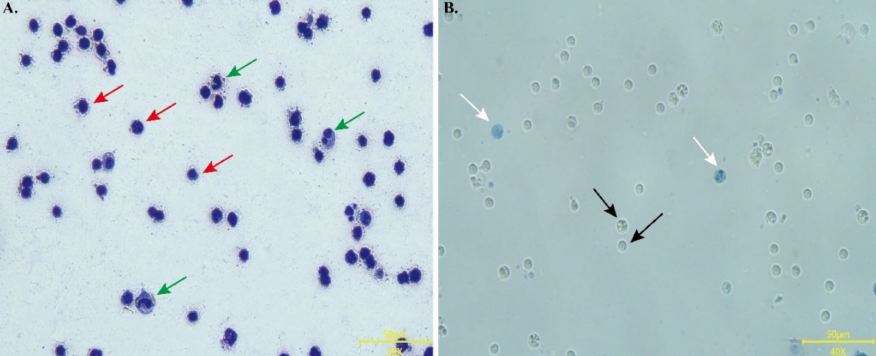
Figure 5. Morphology and viability identification of PBL. ( A ) Morphological characteristics of Wright- Giemsa stained PBL. Under the microscope, a small number of granulocytes (rod-shaped or lobulated nuclei, indicated by green arrows), and a large number of lymphocytes (round nuclei with little cytoplasm and light dark color, indicated by red arrows) were observed. ( B ) Viability detection of PBL using trypan blue staining. Live cells refuse to stain (black arrows) while dead cells are stained blue (white arrows). All pictures were screened at 400 × , scale bar = 50 µ